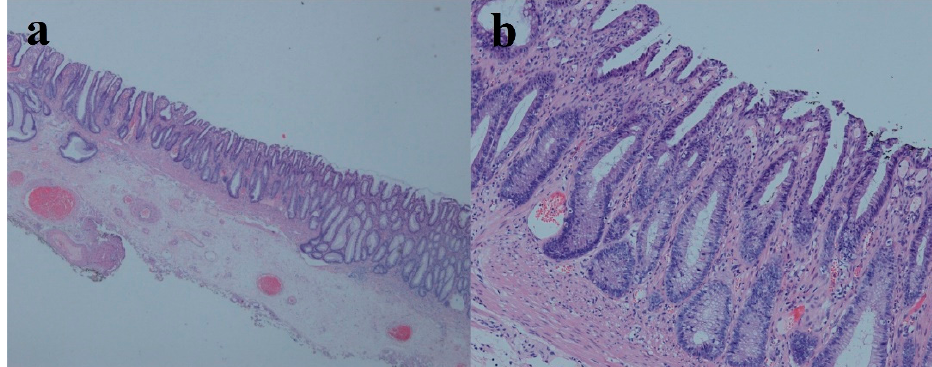
Figure 3. Resection histology: microvascular hyperplasia and musculomucosal hyperplasia. ( a ) Magnification: ×10; ( b ) magnification: ×200.